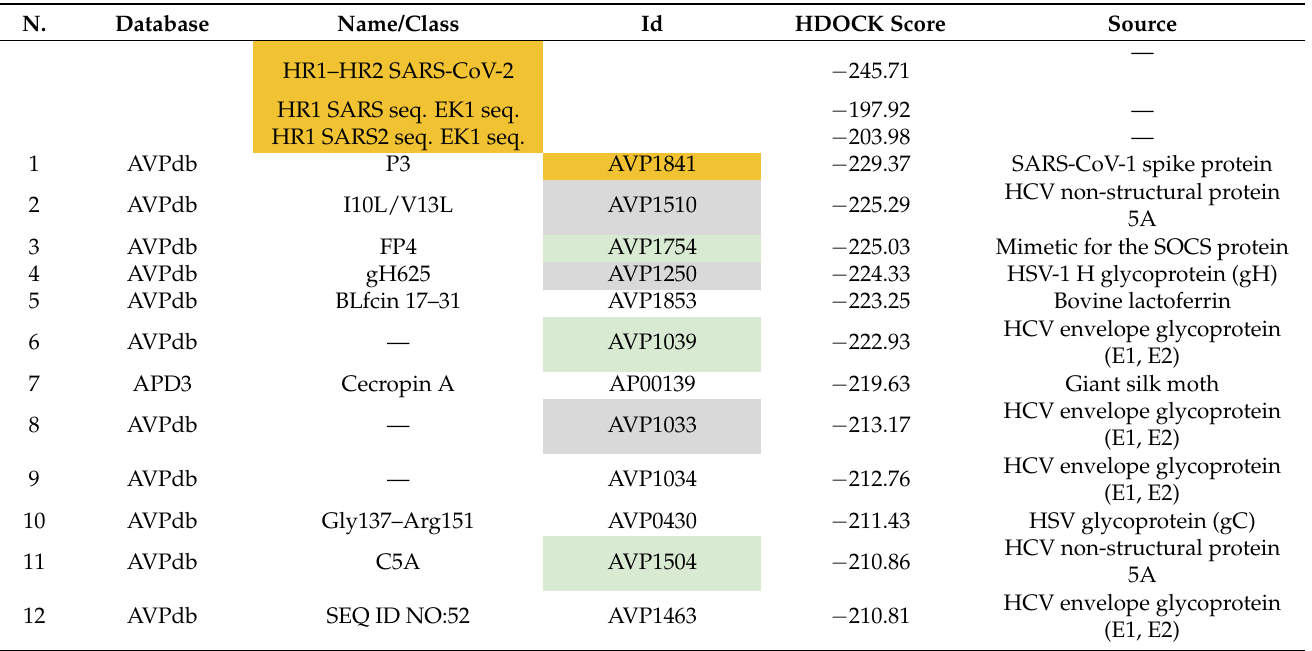
Table 2. Top 50 HDOCK server results for analyzed peptides (the gold color indicates HR1- or HR2-derived peptides, the green color is for chosen peptides and the light green and grey are for possible valuable